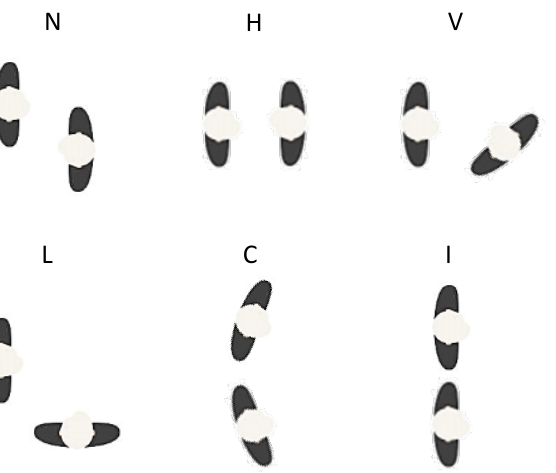
Figure 4. Six basic types of F-formation defined by Ciolek and Kendon